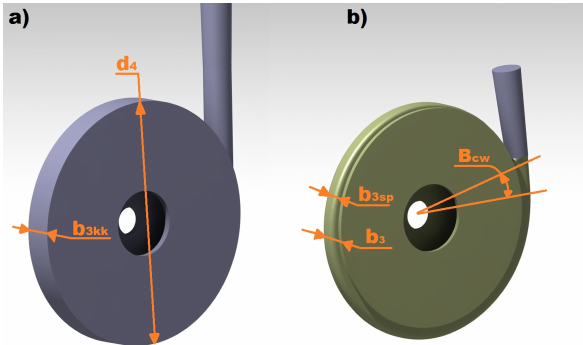
Figure 7: Analysed features of flow geometry for both types of sta- tor: a) annular casing, b) volute